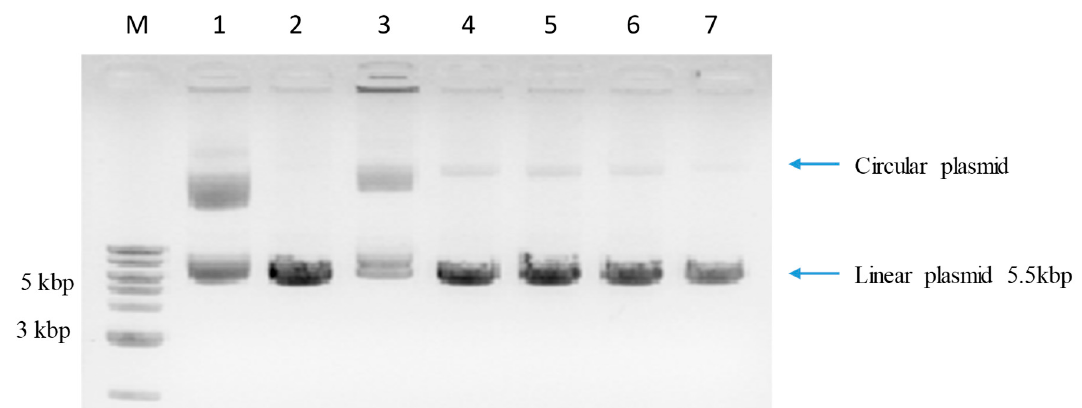
Figure 6. Digestion of pcDNA3.1HisC (total length 5.5kbp) with BamH1 endonuclease. M—marker DNA; 1—not digested plasmid DNA; 2—plasmid DNA digested with BamH1 (DNA present in linear form); 3—plasmid DNA + daunorubicin + BamH1 ; 4—plasmid DNA + 1c + BamH1 ; 5—plasmid DNA